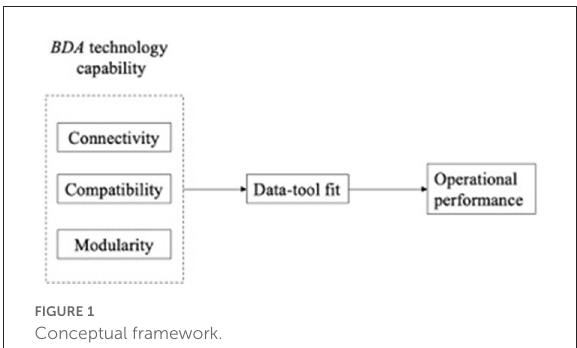
FIGURE1 Conceptual